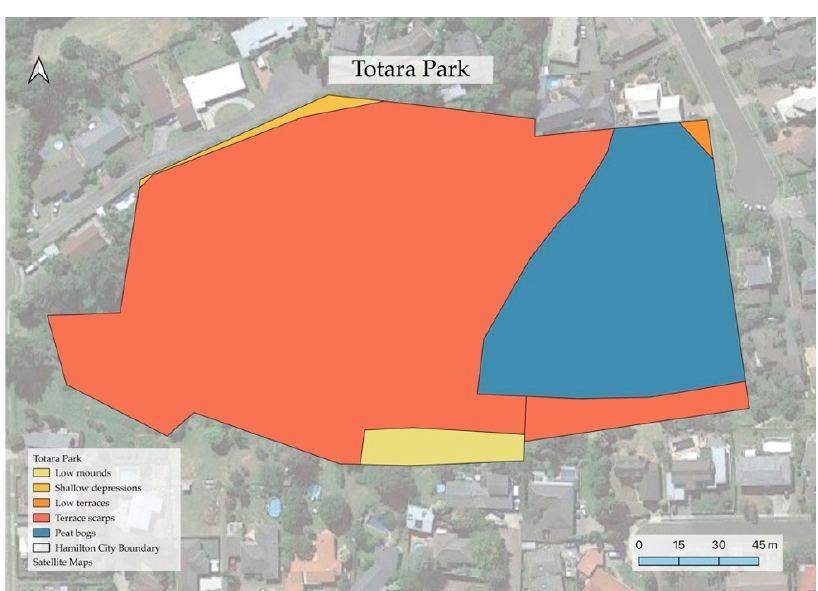
Figure B1. Totara Park’s planting zones. Low mounds (mixed conifer-broadleaf forest); shallow depressions (kahikatea semi-swamp forest); low terraces (totara-matai-kowhai forest); terrace scarps (totara-matai-kowhai forest) and peat bogs (shrub sedgeland). In the terrace scarps ecological unit, appropriate species to plant include Blechnum chambersii , Dacrydium cupressinum , Podocarpus totara , Prumnopitys taxifolia , Olearia rani and Knightia excelsa . Restoration of the open grassy area to the east of the grey willow-kahikatea patch would require less effort. The space could be planted with suitable species for the shrub sedgeland ecological unit, including Leptospermum scoparium , Cordyline australis , Coprosma propinqua , Machaerina teretifolia , M. rubiginosa , Phormium tenax and Carex secta [18].